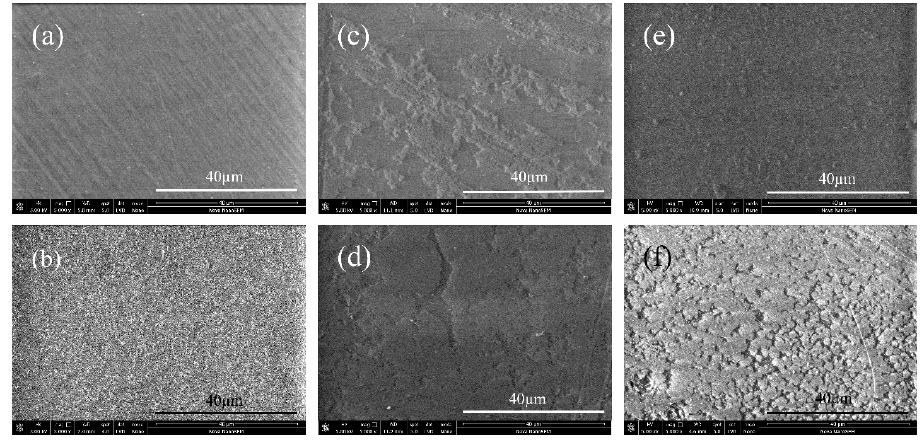
Figure 2. Surface morphology by scanning electron microscope (SEM): ( a ) PE; ( b ) PET; ( c ) PEH; ( d ) PEF; ( e ) PETH; and ( f ) PETF.